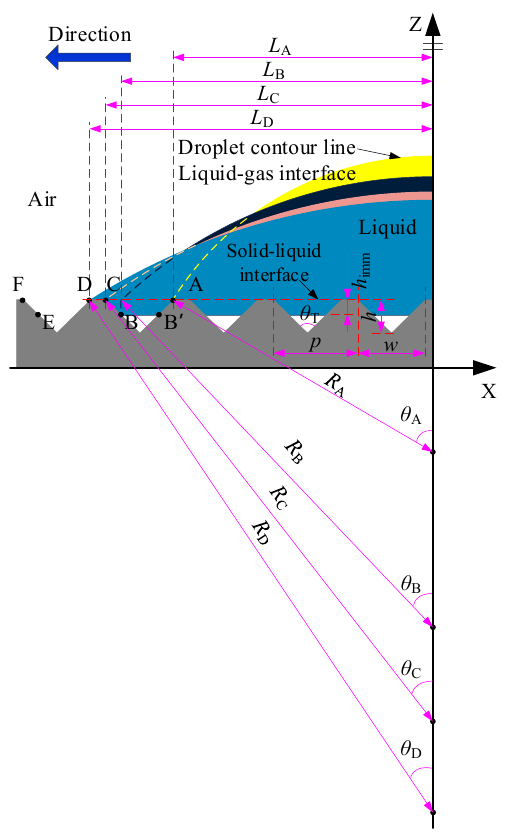
Figure 1. Two-dimensional model of composite infiltration mode. Considering the scale of the microstructure, the liquid surface of the droplet inside the microstructure can be simplified to a straight line. In the modeling, it is assumed that the depth of the liquid immersed into the microstructure is the same, and the immersion